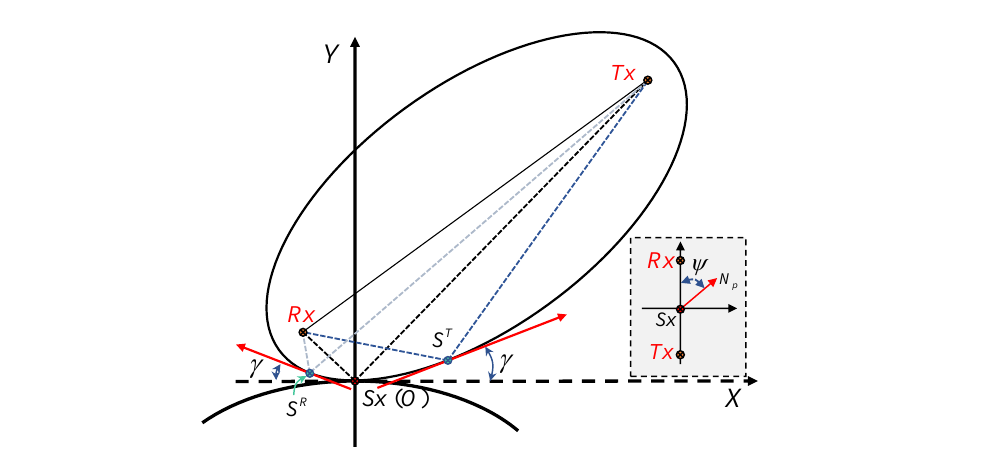
Figure 4. The impact of the surface slope angle, γ , (Note: γ is not in the scattering plane) and aspect on the specular points under the condition when the path range of reflected signals is determined. ψ denotes the relative relationship between the slope aspect, N p , and scattering plane. Alternatively, N p is the projection of the normal vector of the reflected surface on the plane that is tangential to the ellipsoid at the specular point S x . ψ is the angle between N p and the projection of the reflected vector (from the specular point to the receiver) on the same tangent plane at S x .